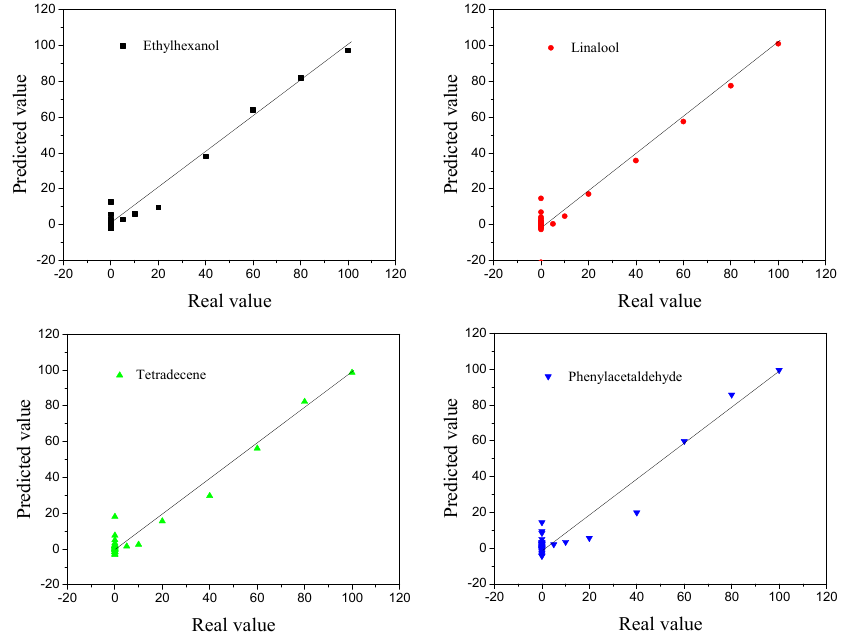
Figure 11. The real value versus the predicted value toward the different concentrations of four VOCs (ethylhexanol, linalool, tetradecene, and phenylacetaldehyde) calculated by neural net fitting (NNF). The correlation coefficient ( R 0 ) and root mean square error ( R SMT ) between the real and predicted concentrations were 0.984 and 4.04, respectively.